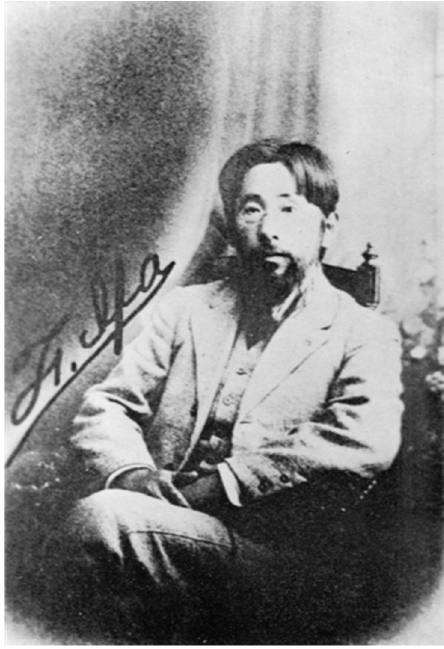
Figure 1. Ifa Fuyū (c. 1912). Figure 1. Ifa Fuy¯u (c.